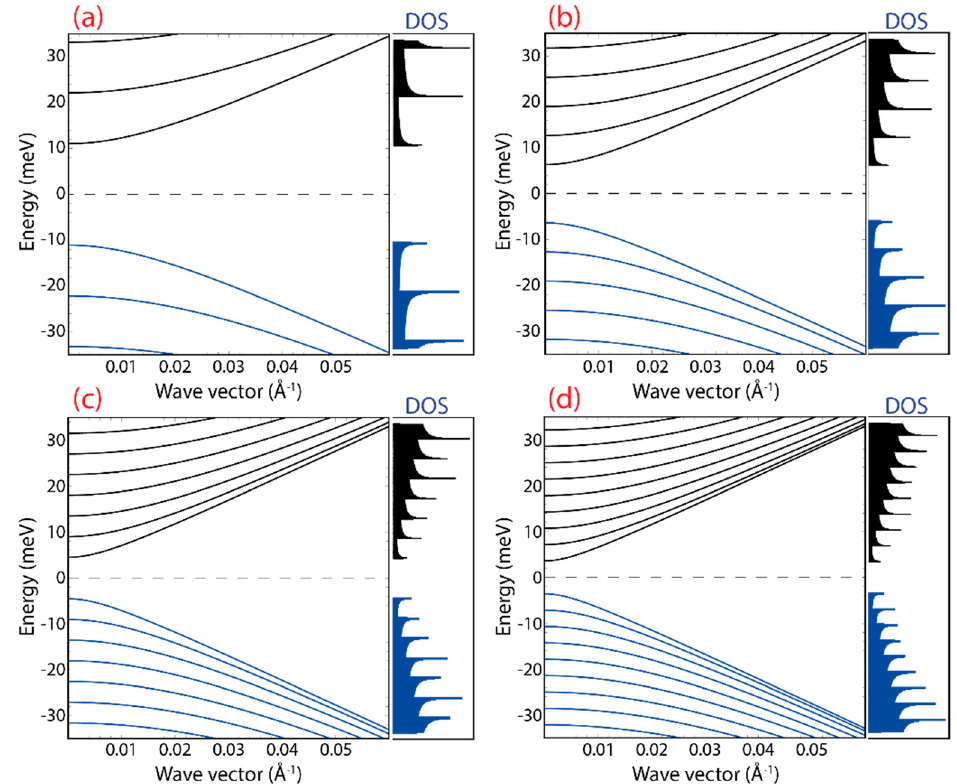
Figure 4. Band structure and density of states (DOS) as a function of parallel component k , considering the experimental realized ribbon widths: ( a ) 155 nm, ( b ) 270 nm, ( c ) 380 nm, and ( d ) 480 nm. Blue and black curves represent the valence and conduction states, respectively.